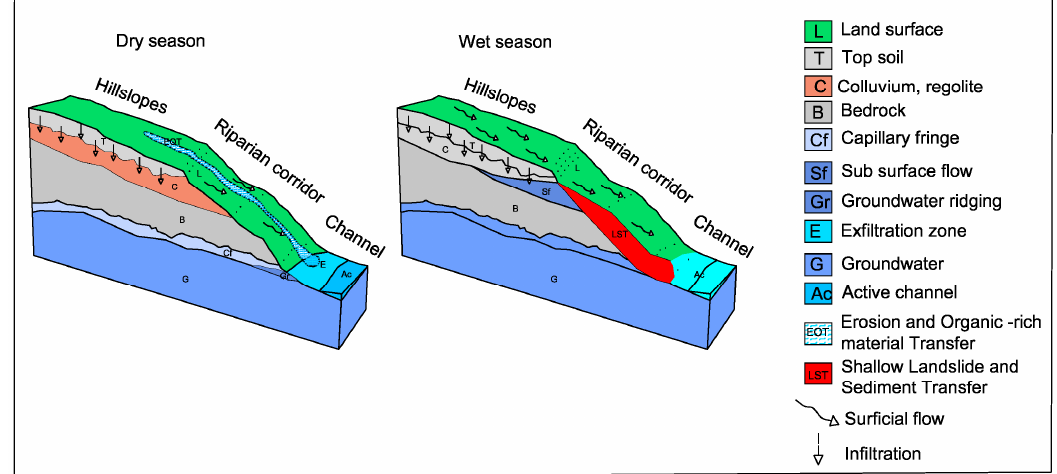
Figure 13. Perceptual model of the Ciciriello catchment.